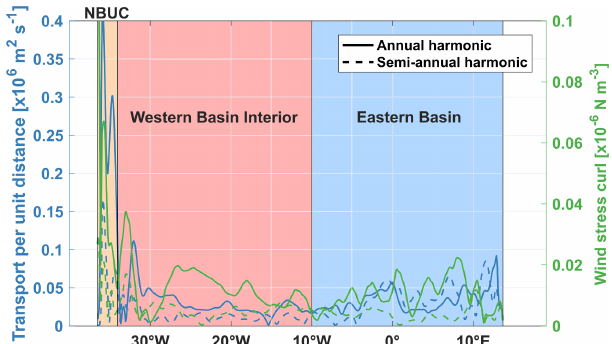
Figure 14. Amplitudes of the annual (solid curves) and semi-annual (dashed curves) harmonics of the vertically integrated upper-ocean geostrophic velocity in INALT01 (blue curves; left axis) and the INALT01 wind stress curl (green curves; right axis) along 11 ◦ S. Transparently shaded boxes highlight different regions – the NBUC (orange), the western basin interior (red) and the eastern basin